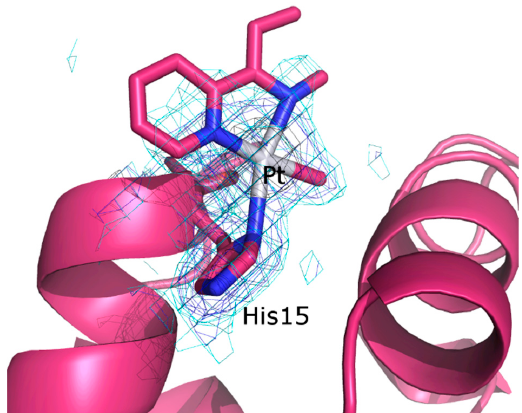
Figure 4. Details of the binding site of complex I fragment in the HEWL adduct. According to our interpretation of the electron density (e.d.) maps, binding of complex I fragment to HEWL is associated with the loss of two Pt ligands, i.e., the iodide, which is probably replaced by the imidazole of the His15 and the olefin. 2Fo–Fc electron density maps are contoured at 3 σ (black), 1 σ (grey), and 0.5 σ (cyan) level. The electron density map associated to dmphen is poorly defined; thus, only a part of this ligand has been included in the final model. The 2Fo–Fc map contoured at 0.3 σ level is reported in Figure S2.